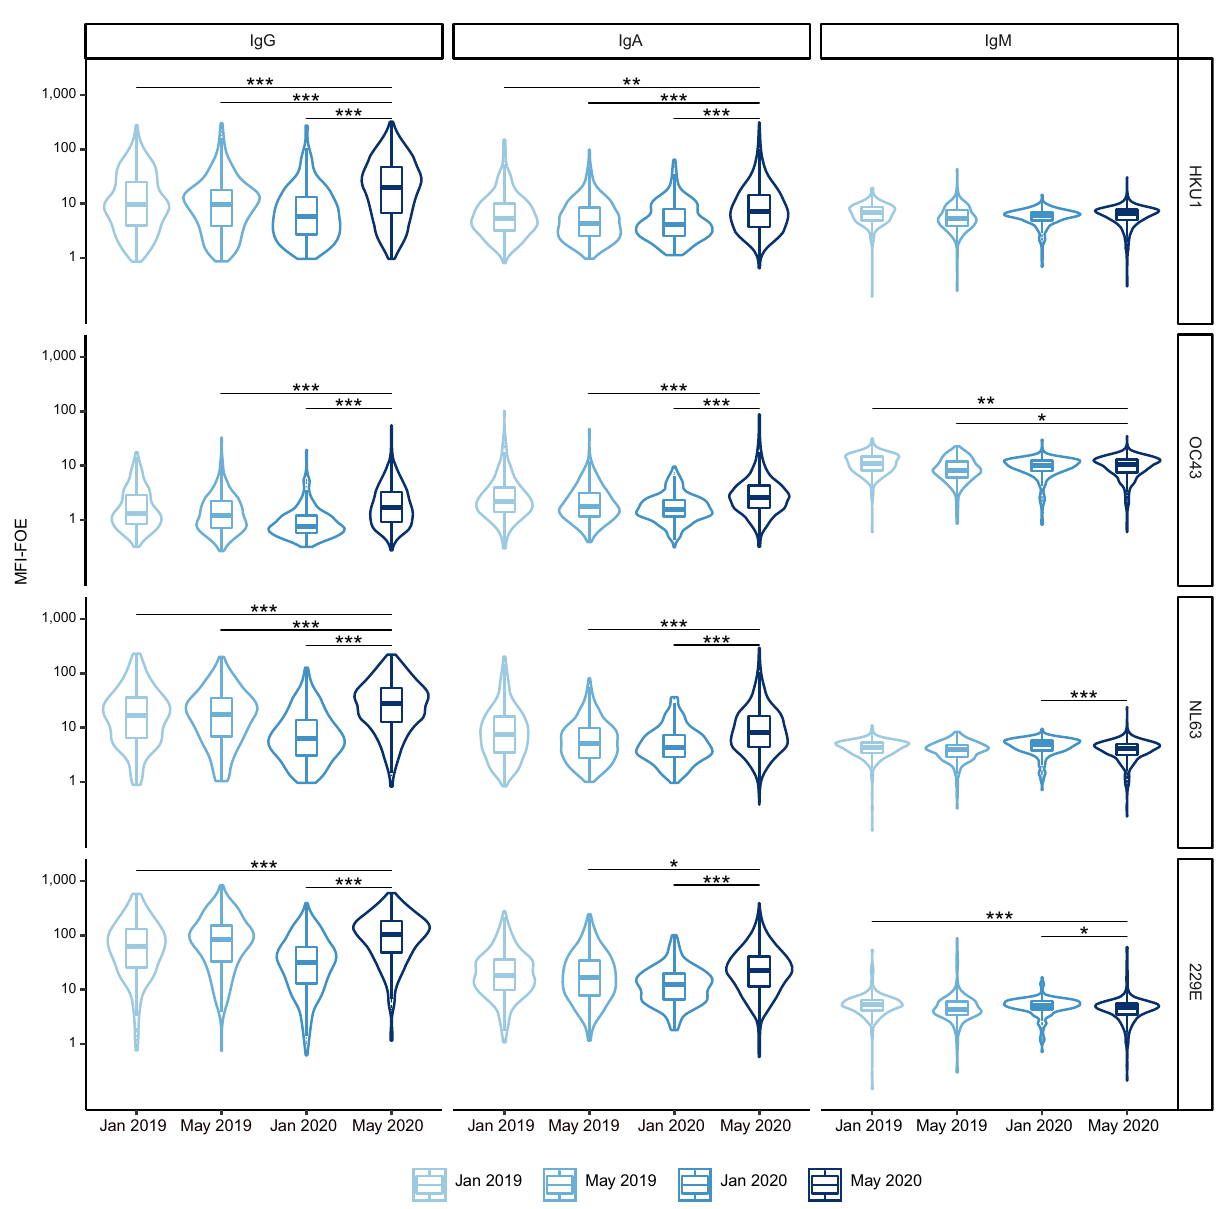
Fig. 6 Seasonal and annual fl uctuation in HCoV reactivity. Reactivity to human coronaviruses (HCoV-NL63, HCoV-229E, HCoV-HKU1, HCoV-OC43) was compared by ABCORA 5.0. Reactivity in healthy blood donors from 2019 and 2020 was compared. Pre-pandemic samples included: January 2019 ( N = 285), May 2019 ( N = 288), January 2020 ( N = 252). Samples from May 2020 ( N = 672) were collected during the pandemic in Switzerland. Only samples without SARS-CoV-2 speci fi c reactivity as de fi ned by ABCORA were included ( N = 653). Stars correspond to levels of signi fi cance of two-sided t -tests comparing the indicated groups. Levels of signi fi cance are corrected by the Bonferroni method for multiple testing and indicated as follows: * p < 0.05/36, ** p < 0.01/36, *** p < 0.001/36. Boxplots represent the following: median with the middle line, upper and lower quartiles with the box limits, 1.5x interquartile ranges with the whiskers and outliers with